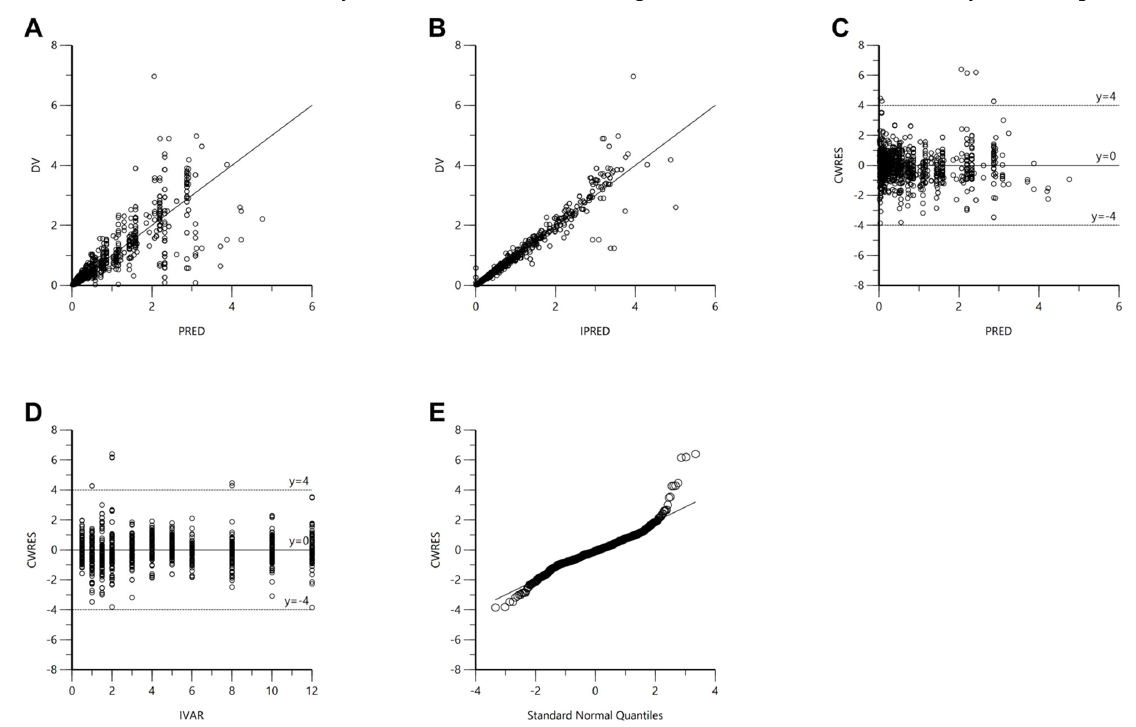
Figure 4. GOF plot results for the final torsemide Pop-PK model. DV versus PRED ( A ). DV versus IPRED ( B ). CWRES versus PRED ( C ). CWRES versus IVAR ( D ). CWRES versus quantile–quantile plot of components ( E ). Table 5. Bootstrap results of the finally established human Pop-PK model for